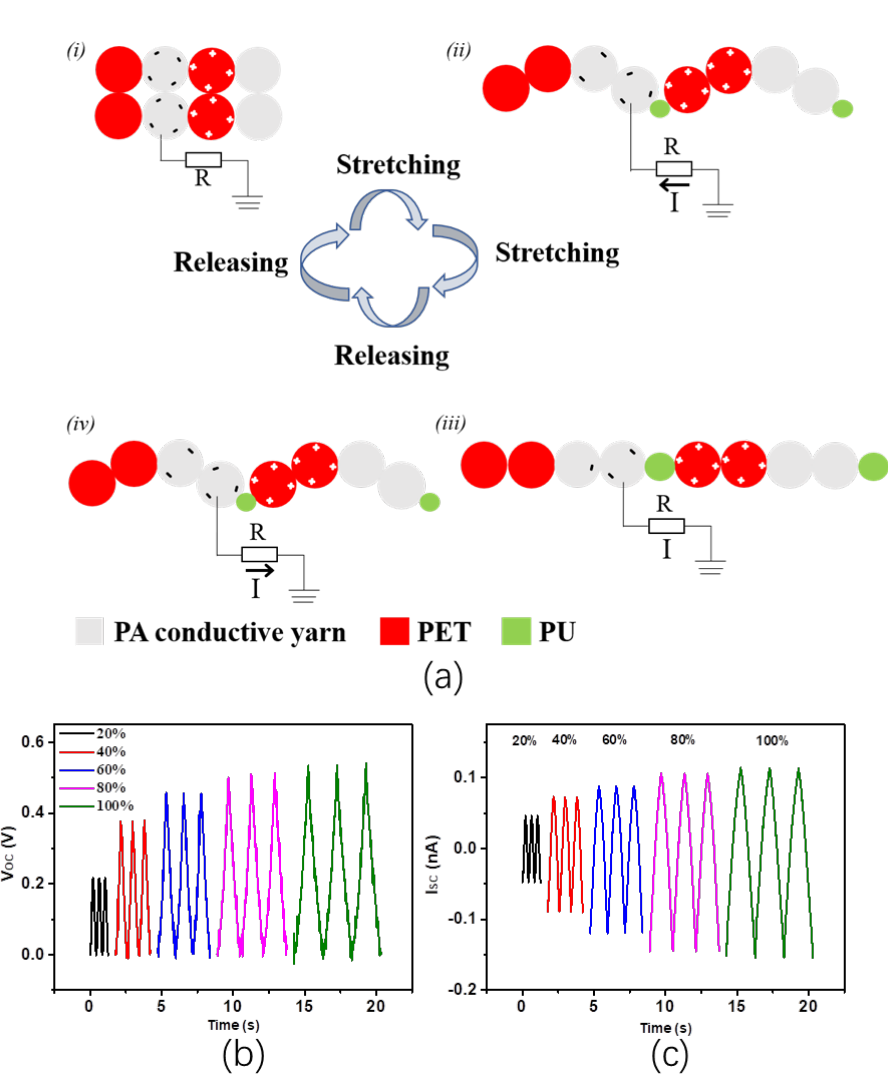
Figure 3. ( a ) The working mechanism of SWF-TENG with a satin weave, ( i ) In the original state without stretch; ( ii ) The SWF-TENG is gradually stretched; ( iii ) The SWF-TENG is stretched to the largest deformation; ( iv ) The SWF-TENG is recovering to the original state; ( b , c ) Electrical output performances of SWF-TENG with satin